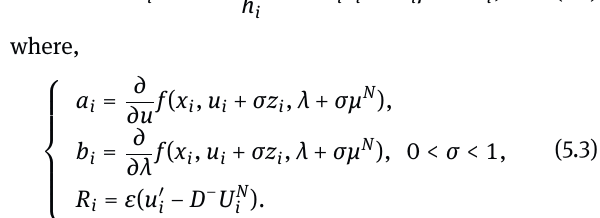
Adaptive mesh generation